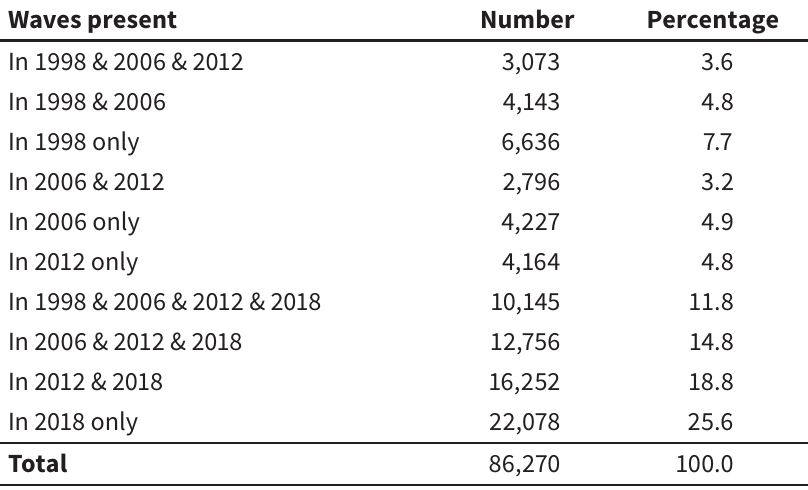
Individuals present in various combinations of waves,